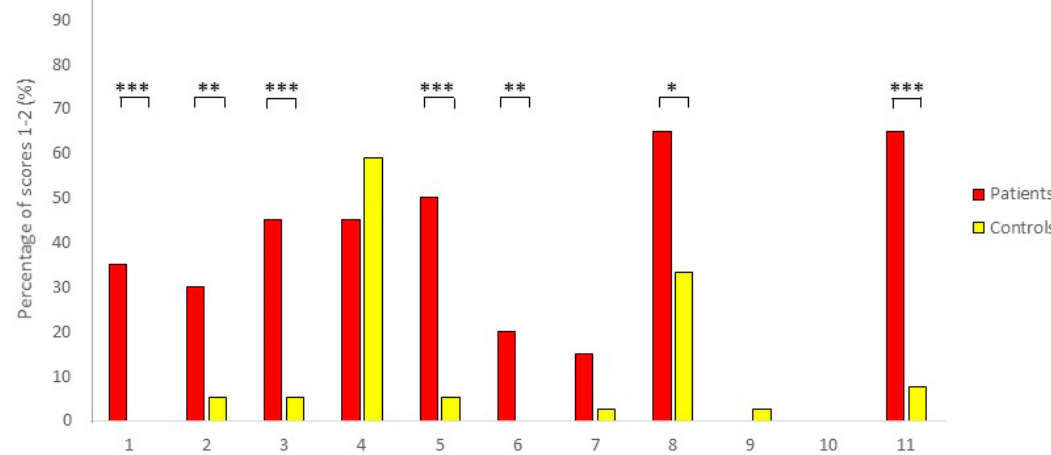
Figure 3. EQUUS-FAP FOAL (Equine Utrecht University Scale for Facial Pain Assessment for foals) frequency distribution; facial action unit 1: head movement, facial action unit 2: eyelids, facial action unit 3: focus, facial action unit 4: nostrils, facial action unit 5: corners mouth/lips, facial action unit 6: muscle tone, facial action unit 7: yawning, facial action unit 8: smacking with the lips, facial action unit 9: teeth grinding, facial action unit 10: moaning, facial action unit 11: ears. Percentage of scores 1–2 (%) = percentage of foals that had a score of 1 or above for each facial action unit, *= p < 0.05, **= p < 0.01, ***= p < 0.001. ( n = 20 patients, n = 39 controls).